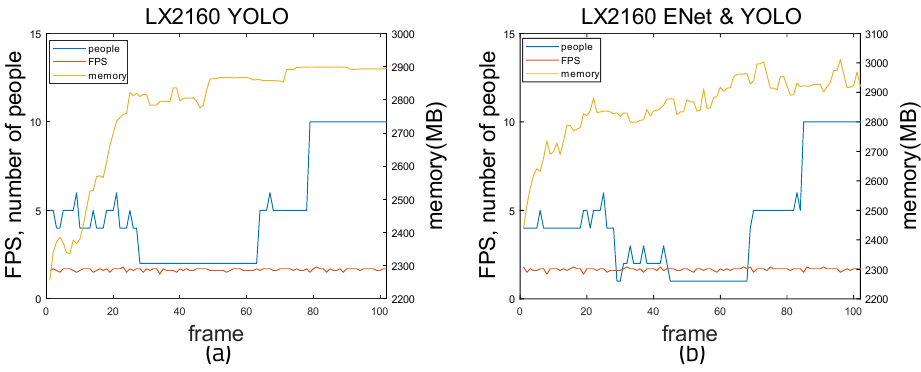
Figure 21. Time measurement result of LX2160 board: ( a ) YOLO and ( b ) ENet and YOLO.